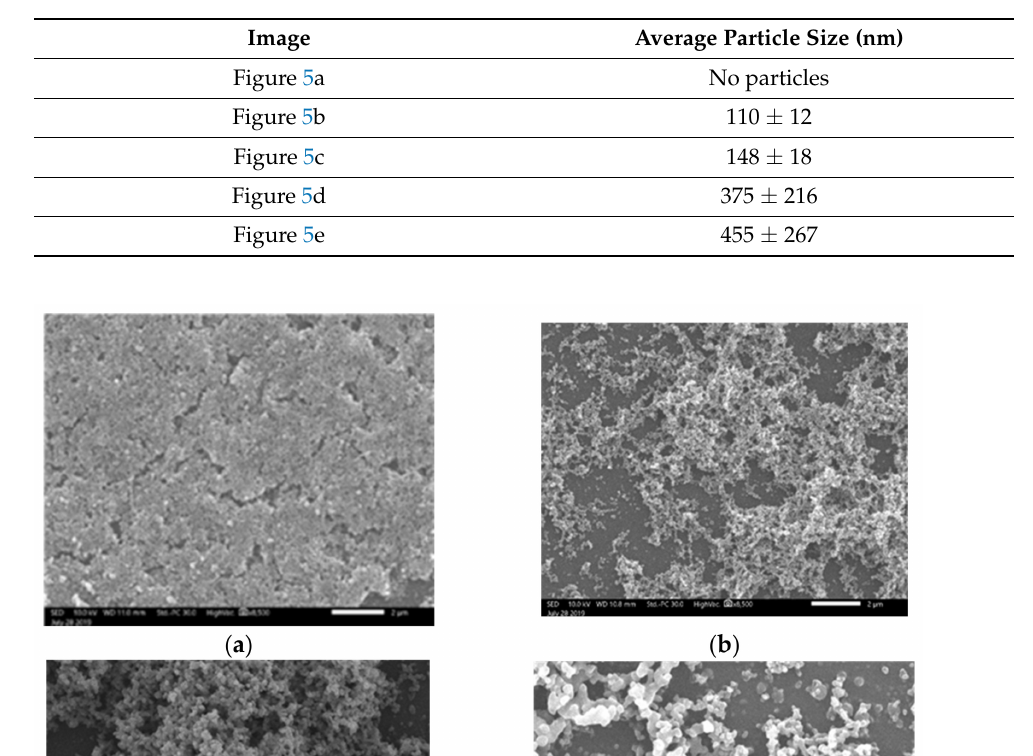
Table 3. Average particle size measured from the SEM images in Figure 5 at the following TEOS:DTMS ratios: Figure 5a: 7:3; Figure 5b: 6:4, Figure 5c: 5:5; Figure 5d: 4:6; and Figure 5e: 3:7.